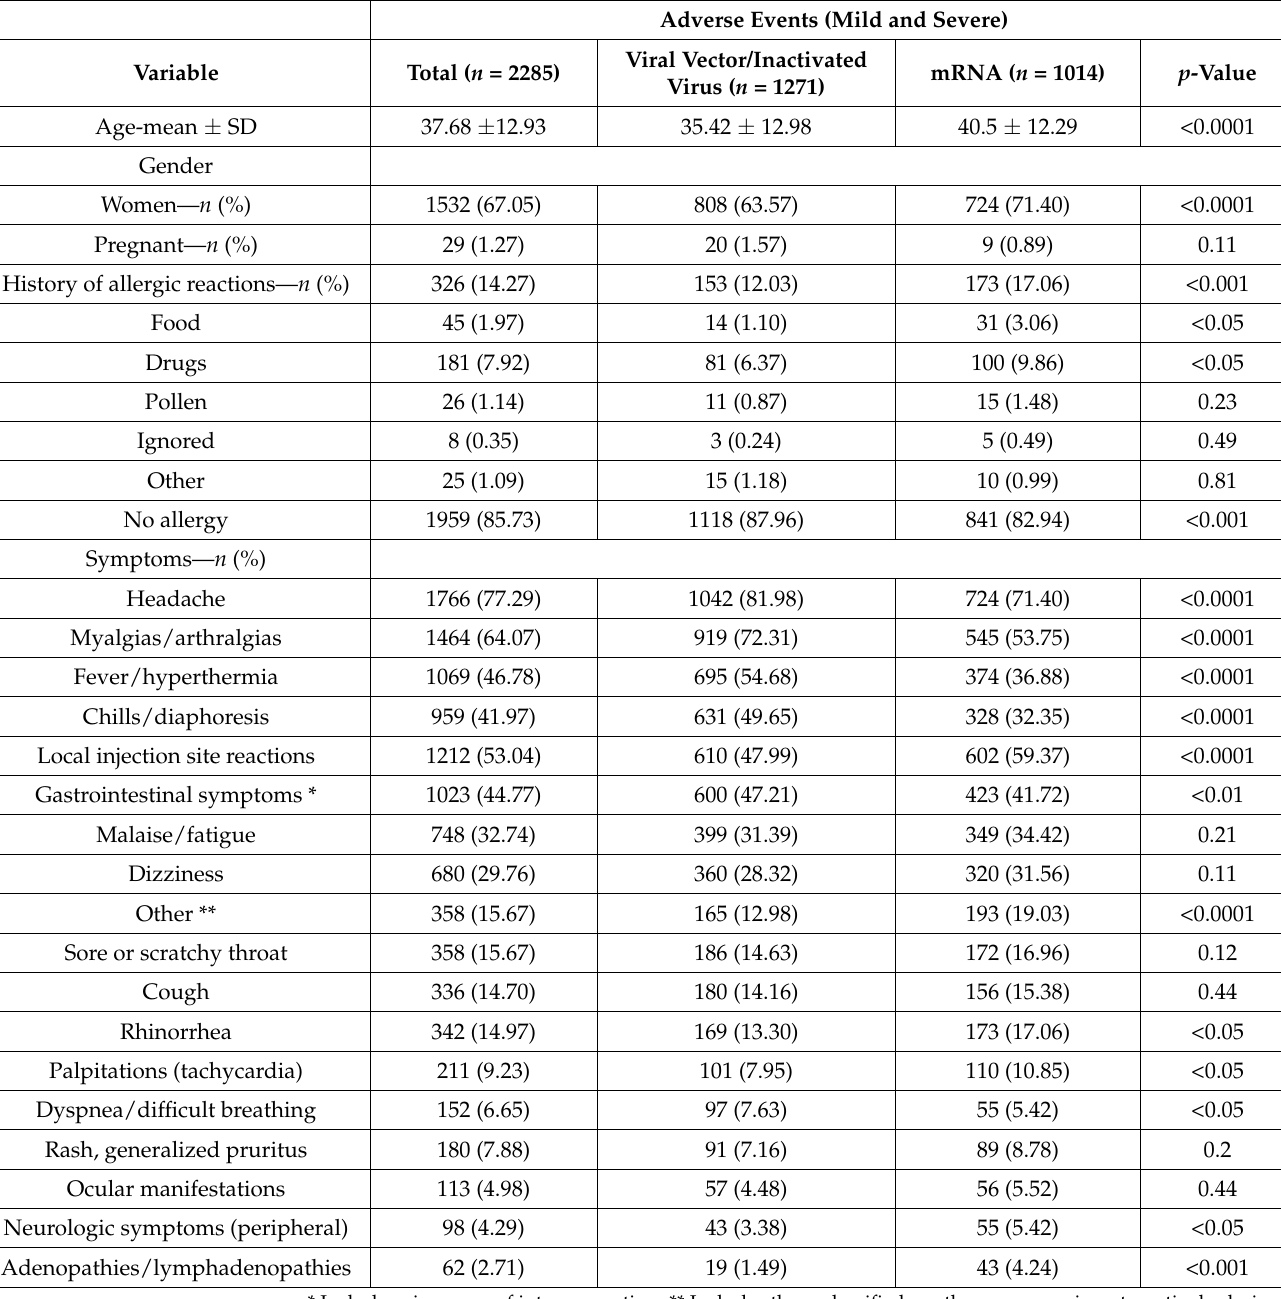
Table 2. Age, sex, and symptoms distribution by vaccine platform (viral vector and